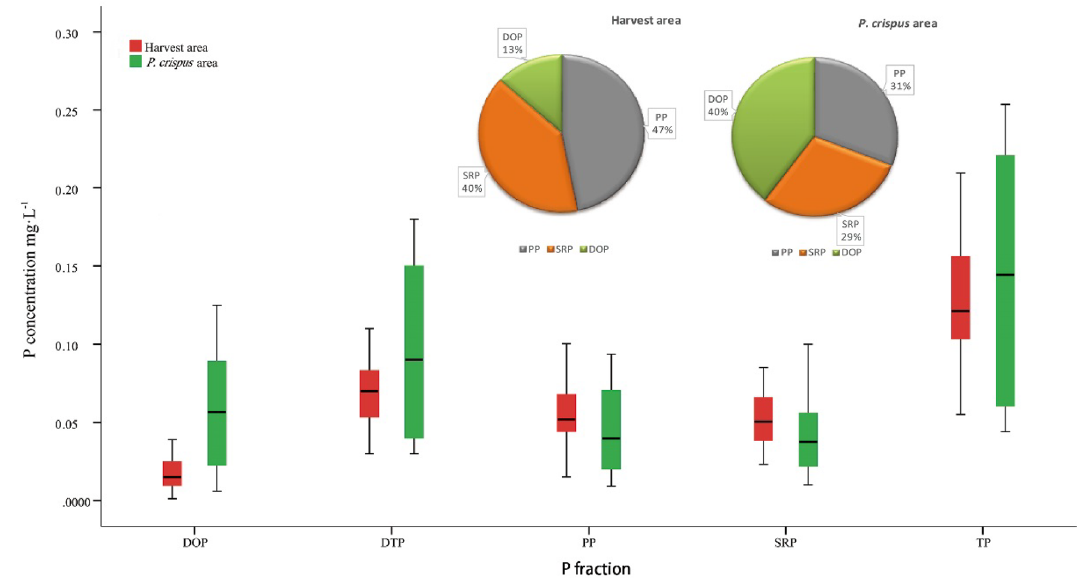
Figure 5. Box plots of different P fractions and P structure in water in different areas of Yimeng